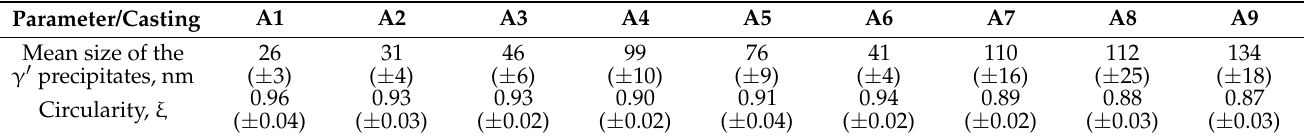
Table 3. γ’ precipitates size in the dendritic regions.